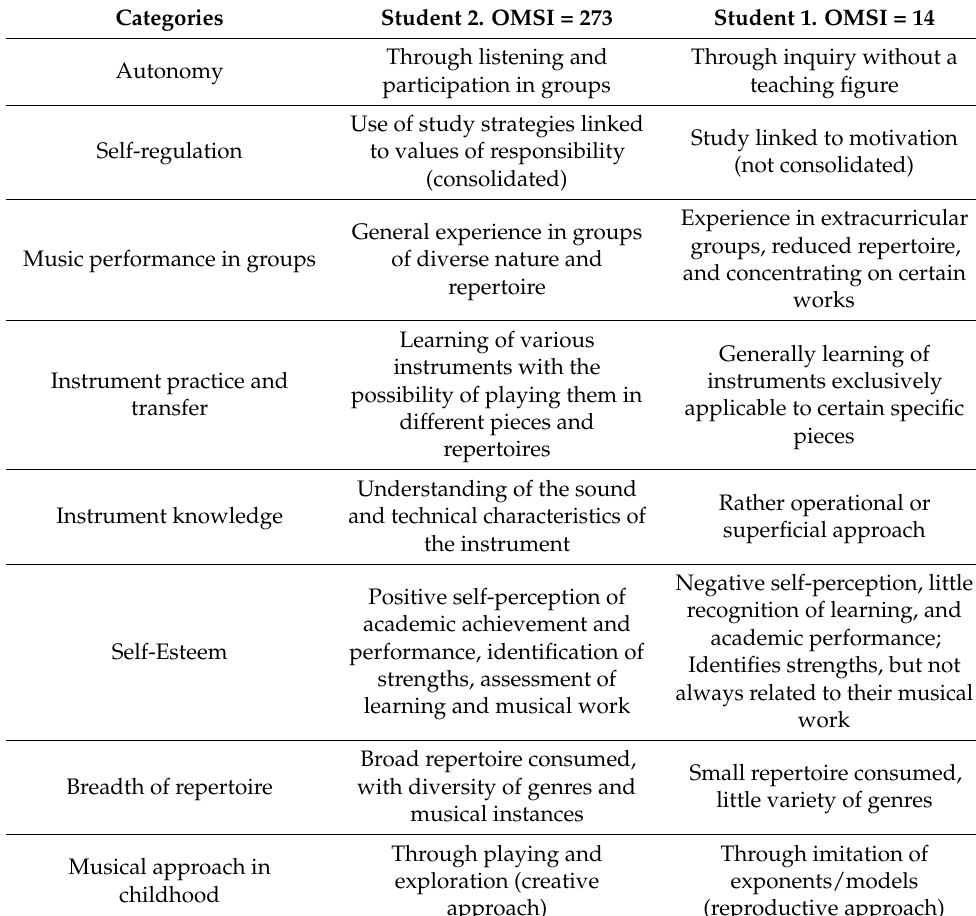
Table 3. Emerging categories of verbalizations and comparative synthesis between interviewees with different degrees of musical